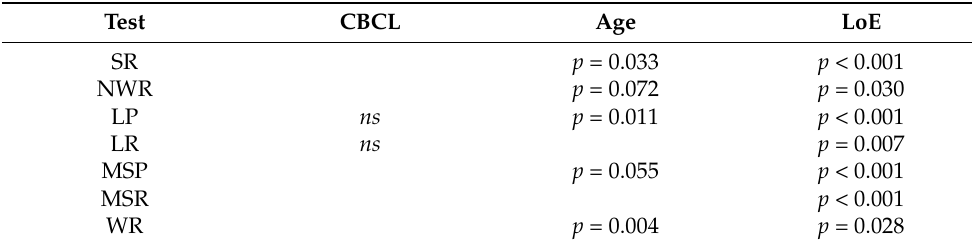
Table 3. Summary of the predictors involved in best fit models assessing the role of CBCL and individual variables on language measures. Test CBCL